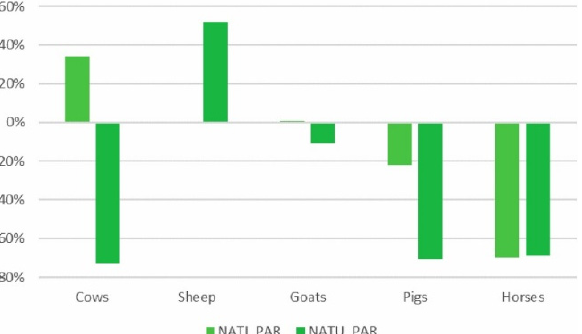
Figure 9. Sierra Nevada-variation in livestock numbers between 1989 and 2009. Source: Drawn up by the authors using data from the 1989 and 2009 Agrarian Censuses, Ministry of Agriculture. Trends in the Specialization in Cattle (1989–2009)